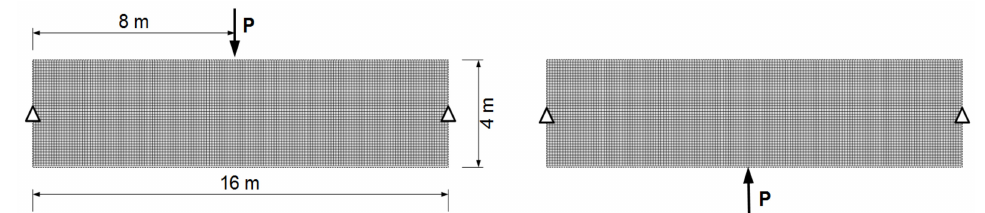
Figure 11. The rectangular structure (16 m × 4 m) applied to two load schemes and